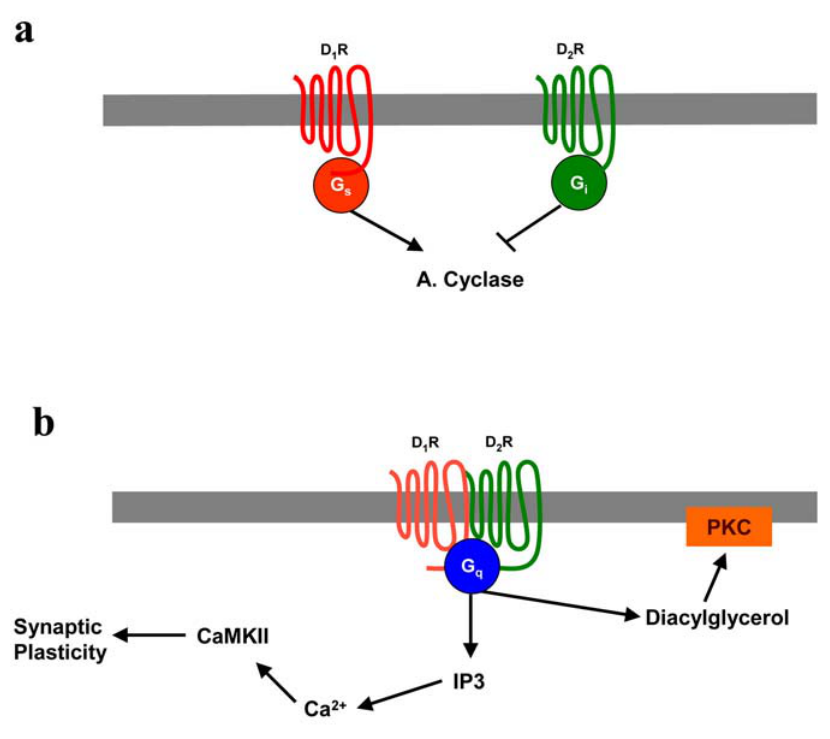
FIGURE 5. Biochemical fingerprint of the dopamine D 1 -D 2 receptor heterodimer. (a) When not forming heterodimers, D 1 receptor couples to G s proteins, whereas D 2 receptor couples to G i proteins. (b) G q selectively couples to D 1 -D 2 receptor heterodimers, which in turns leads to a dopamine- and calcium-dependent activation of calcium calmodulin kinases, with possible implications for synaptic